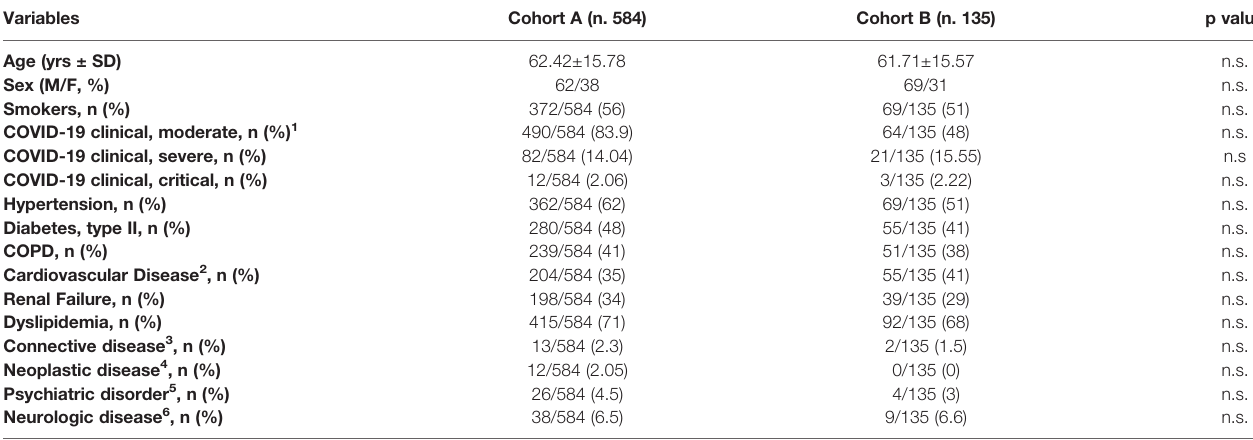
TABLE 1 | Descriptive characteristics of the patients hospitalized for